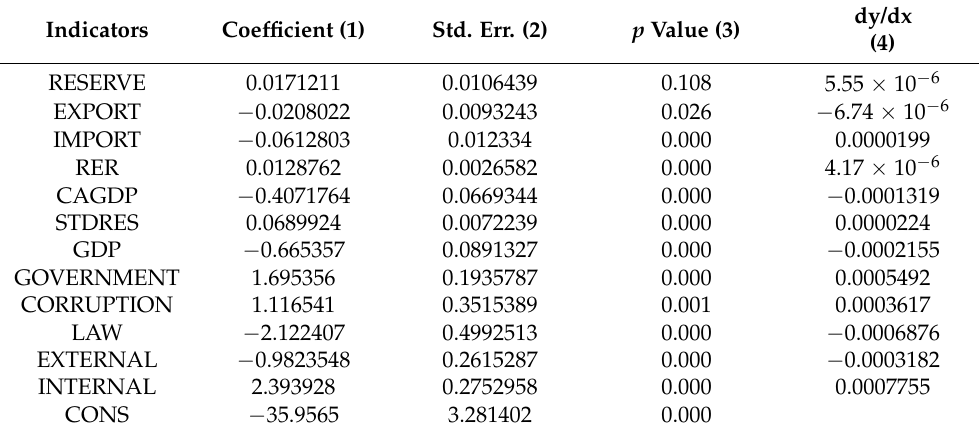
Table 4. Empirical results of logit regression of the 12-month EWS